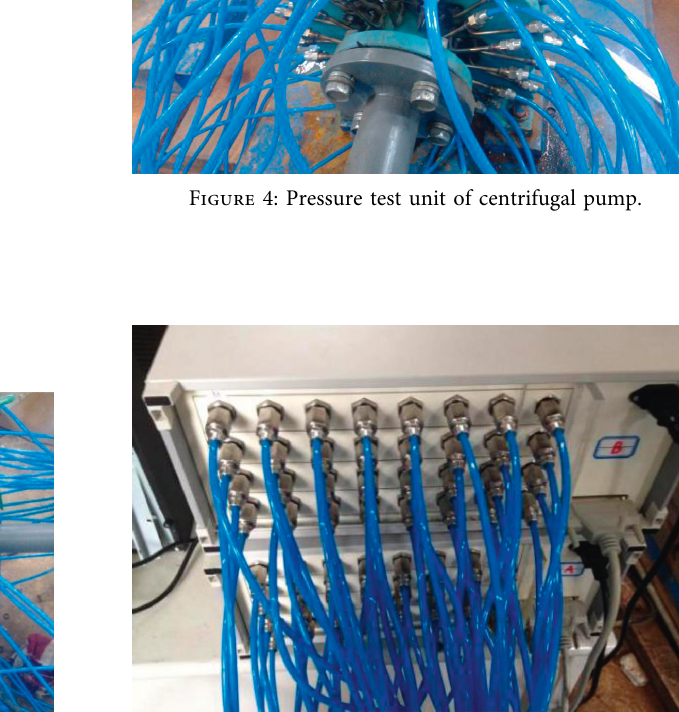
Figure 3: The test unit of pressure field of centrifugal pump.